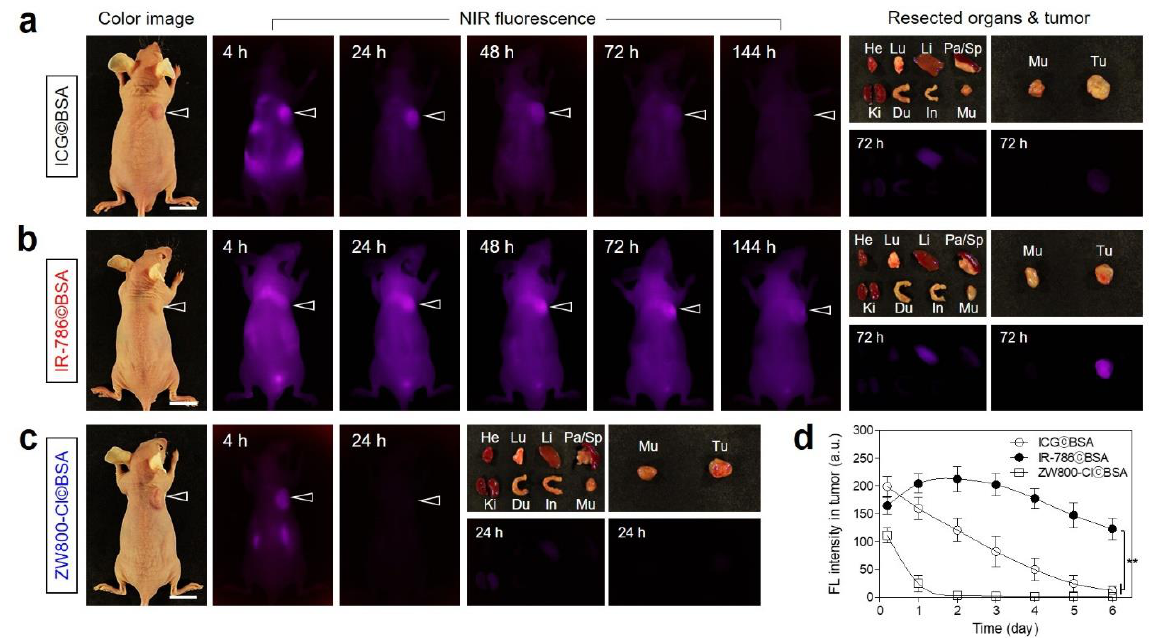
Figure 5. In vivo HT-29 tumor targeting efficiency and biodistribution of ( a ) ICG©BSA, ( b ) IR-786©BSA, and ( c ) ZW800-Cl©BSA complexes. ( d ) Time-dependent fluorescence intensities at the tumor sites targeted by dye©BSA complexes. The tumor site and resected major organs were imaged after injection of each dye©BSA complex during a designated period of time, respectively. The tumor sites are indicated by arrowheads. Abbreviations: Du, duodenum; He, heart; In, intestines; Ki, kidneys; Li, liver; Lu, lungs; Mu, muscle; Pa, pancreas; Sp, spleen; Tu, tumor. Scale bars = 1 cm. Images are representative of 3 mice per treatment group. All NIR fluorescence images had identical exposure times and normalization. Data are expressed as mean ± S.D. ( n = 3, ** p < 0.01).